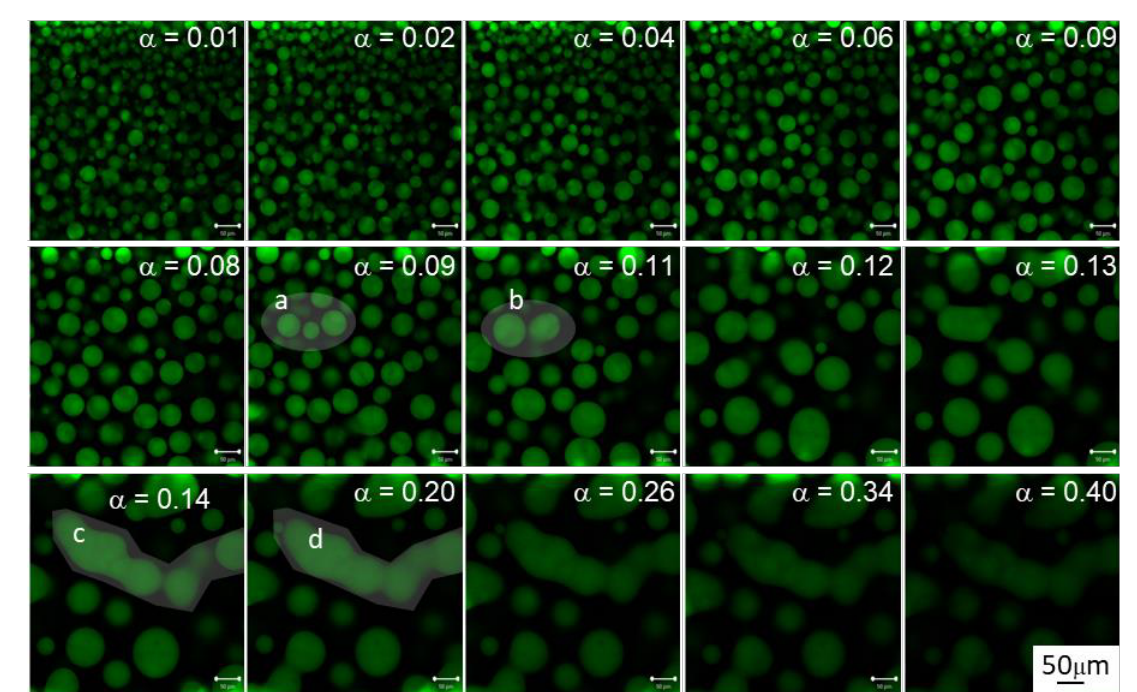
Figure 4. Evolution of HDGEBA/PAMS system morphology at several epoxy conversions ( α ) at 40 °C. Inserts ( a , b ) and ( c , d ) correspond to two coalescence events. The scale bar is 50 µm .